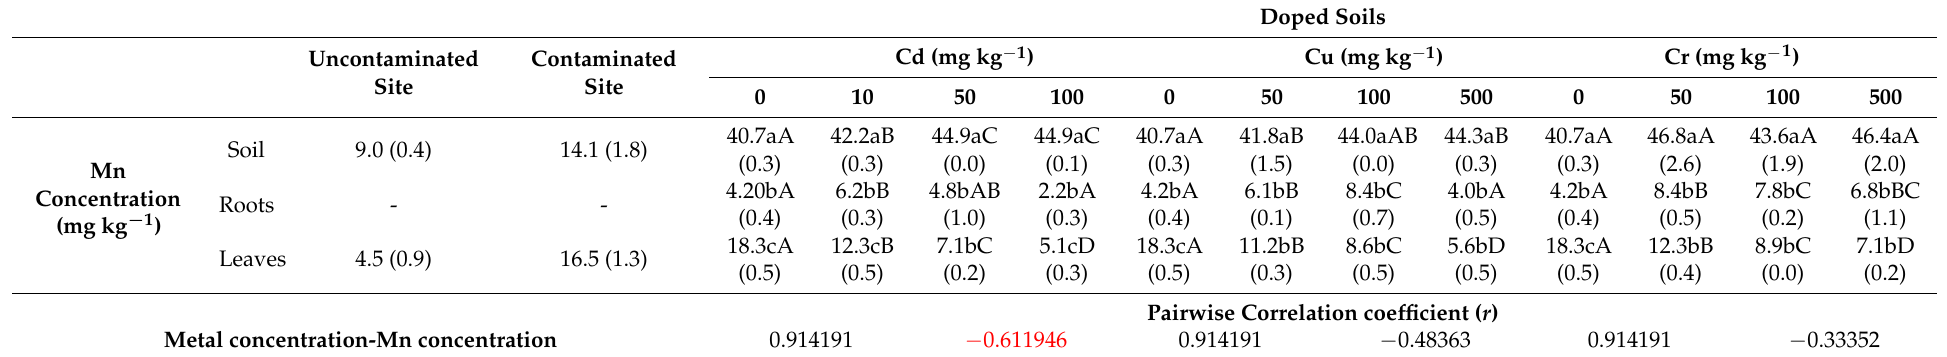
Table 3. Mn content in different compartments of site collected samples and ex-situ experiments.